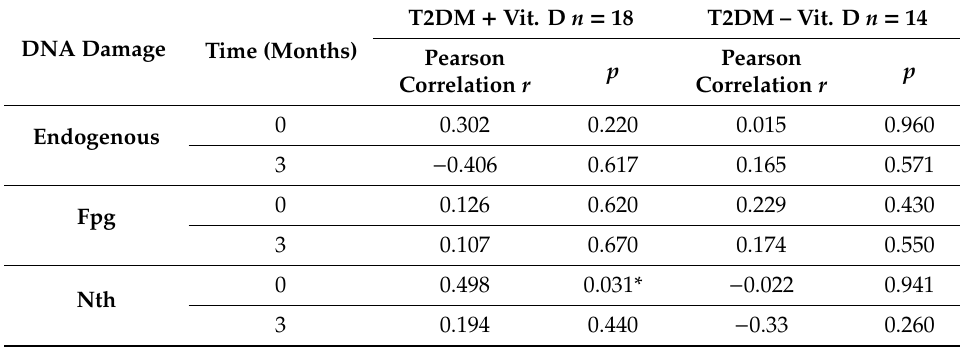
Table 5. The correlation between HbA1c and endogenous and oxidative DNA damage in patients with T2DM (T2DM + Vit. D and T2DM − Vit. D) at baseline and after three months of